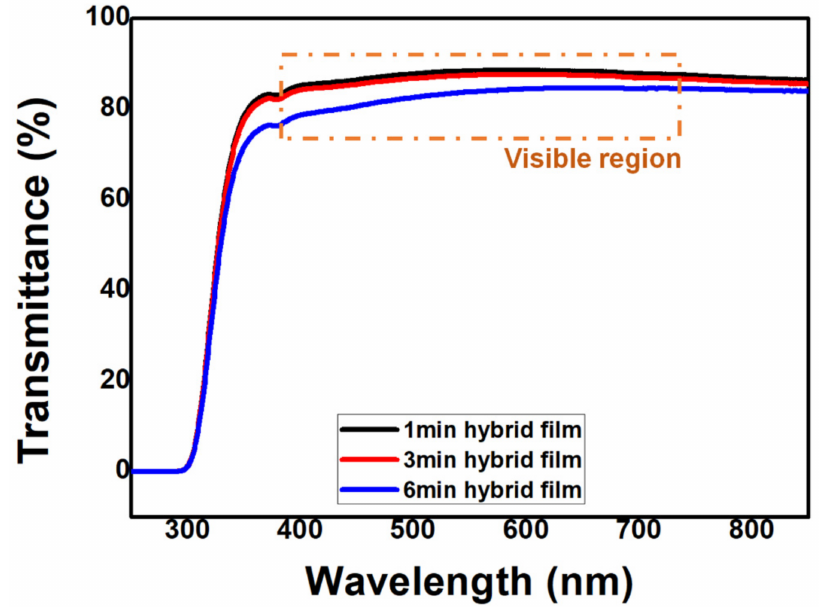
Figure 5. Optical transmittance graphs of the UV-curable polymer/AlSnO hybrid films according to UV-irradiation time for the wavelength range of 250–850